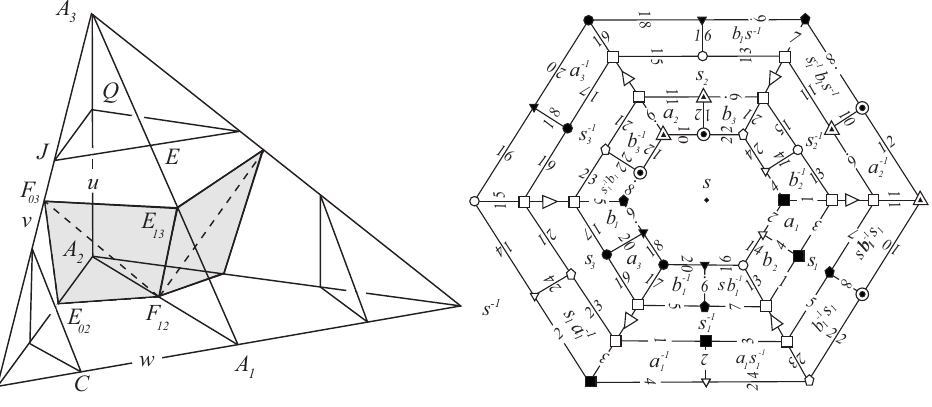
Figure 6. Cobweb manifold Cw ( 6,6,6 ) as a